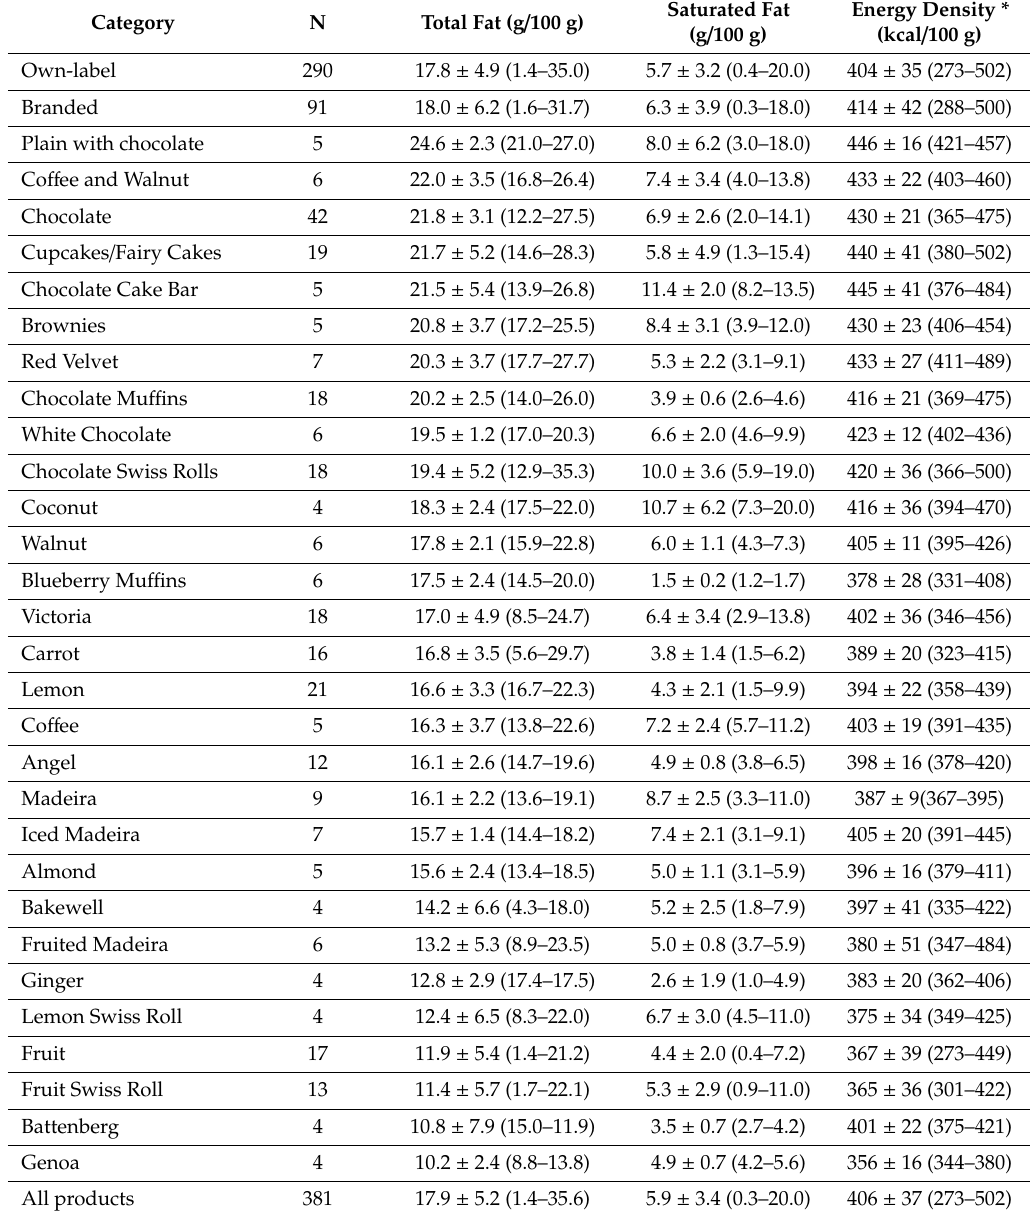
Table A1. Total and saturated fat content and energy density in di ff erent categories of cakes, mean ± SD